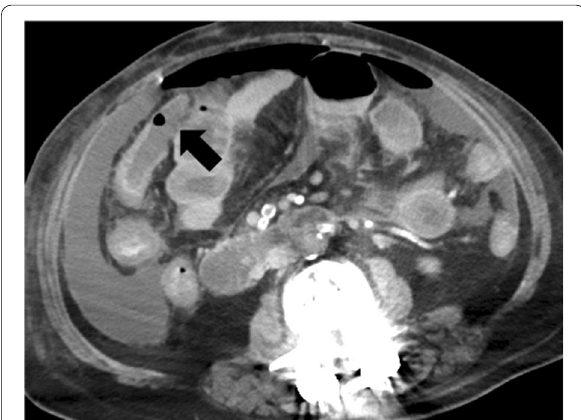
Fig. 2 Computed tomography before emergency surgery showed massive ascites and free air as well as wall defects of the transverse colon (arrow)